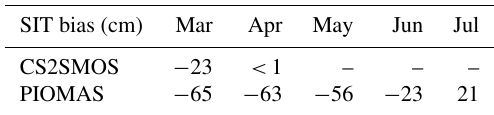
Table 3. Monthly mean biases of TOPAZ4 SIT in the ESS relative to the CS2SMOS and PIOMAS SIT